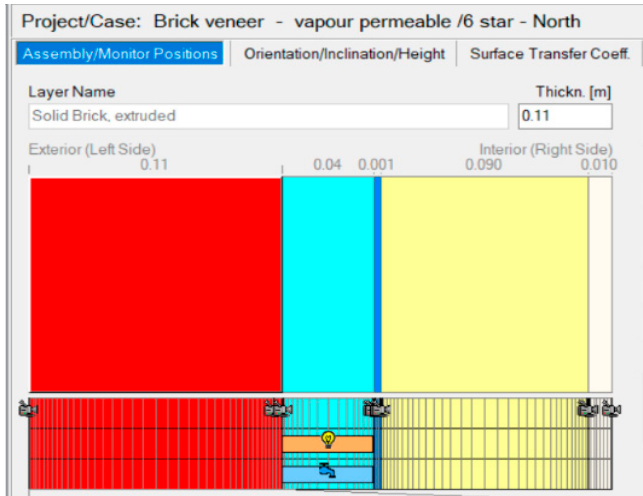
Figure 7. Example of a typical code ‐ compliant clay masonry veneer wall—the base model. Table 6. Default settings of a typical clay masonry veneer wall.